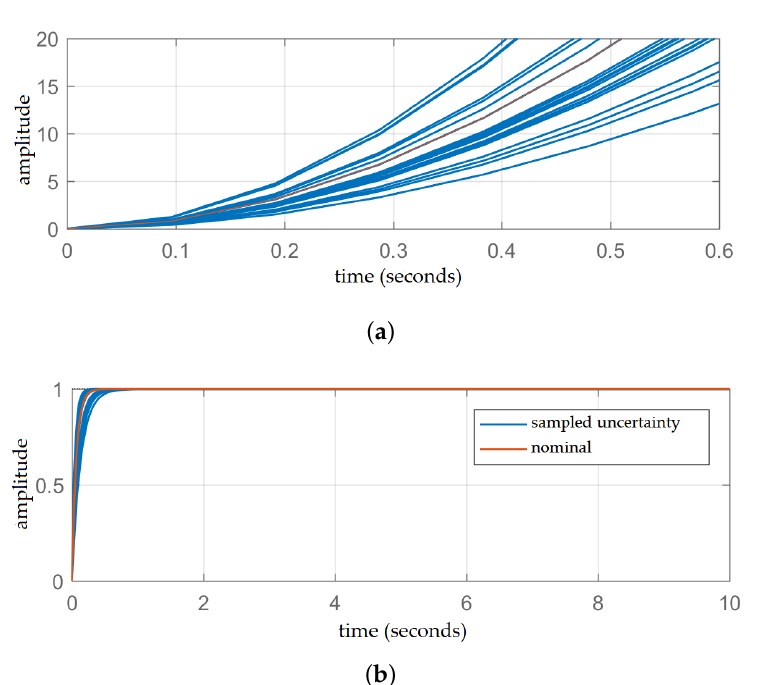
Figure 12. Plant’s open-loop step in the presence of parametric uncertainty ( a ) and the proposed synthesis performance for the model’s uncertainty ( b ).